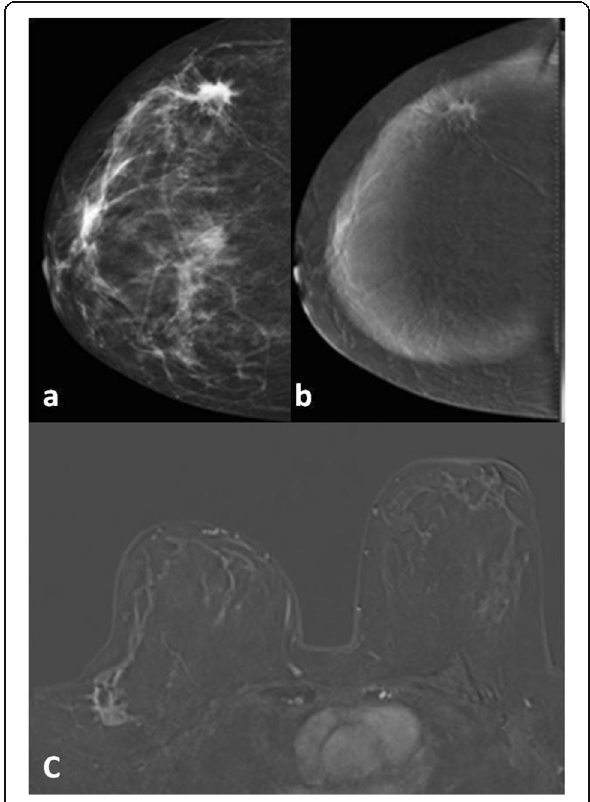
Fig. 1 Forty-six-year-old patient presented by a lump in the right breast. Sonomammography (SM) revealed a speculated mass lesion at right breast upper outer quadrant (UOQ) ( a ). CEM showed an irregular speculated heterogeneous moderate enhancing mass lesion in right UOQ with associated heterogeneous linear non-mass enhancement ( b ). DCE-MRI showed an irregular speculated heterogeneous intense enhancing mass lesion in right UOQ with associated linear heterogeneous non-mass enhancement ( c ). The final diagnosis was invasive lobular carcinoma with